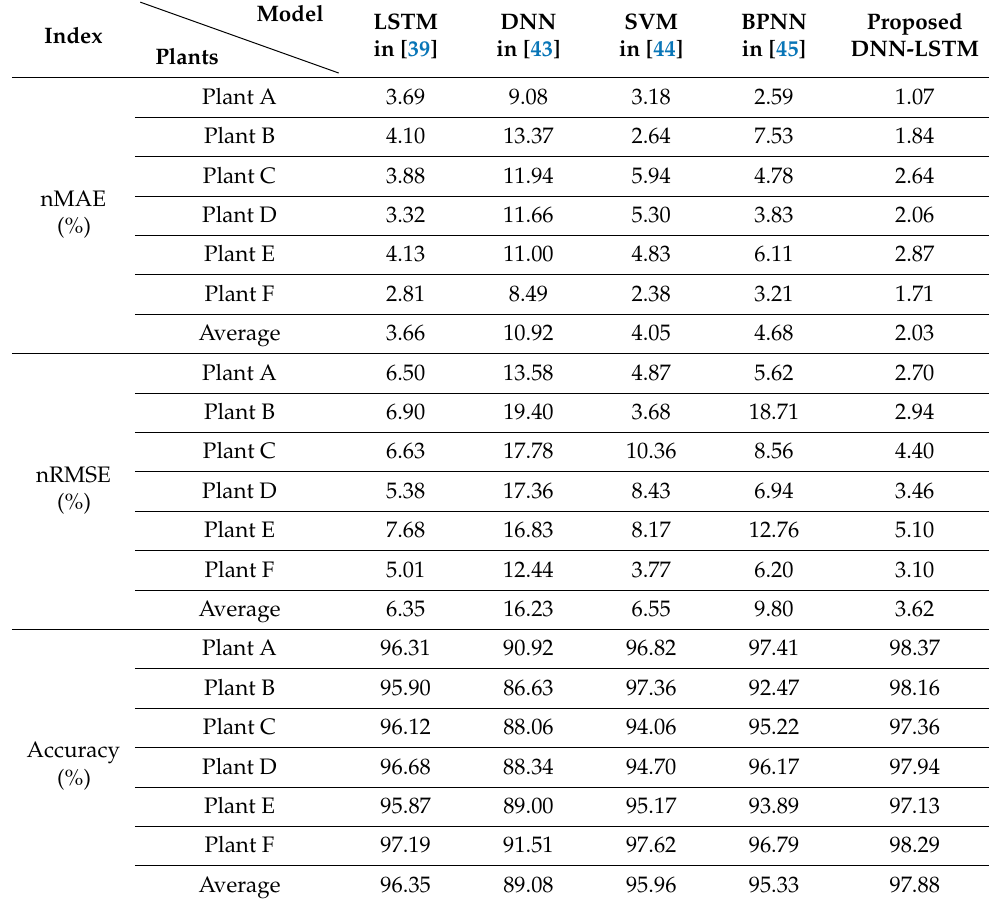
Table 11. Average performance indicators of five forecasting models for six actual solar power plants in